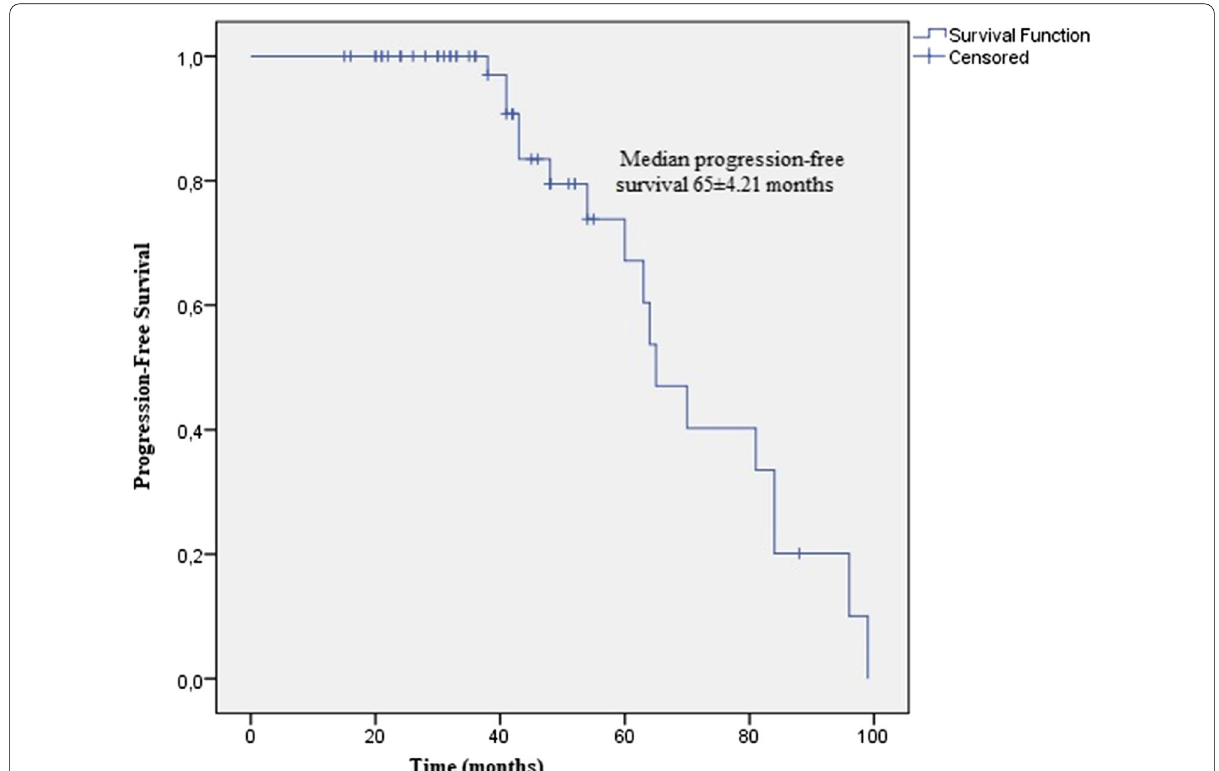
Fig. 1 Median progression-free